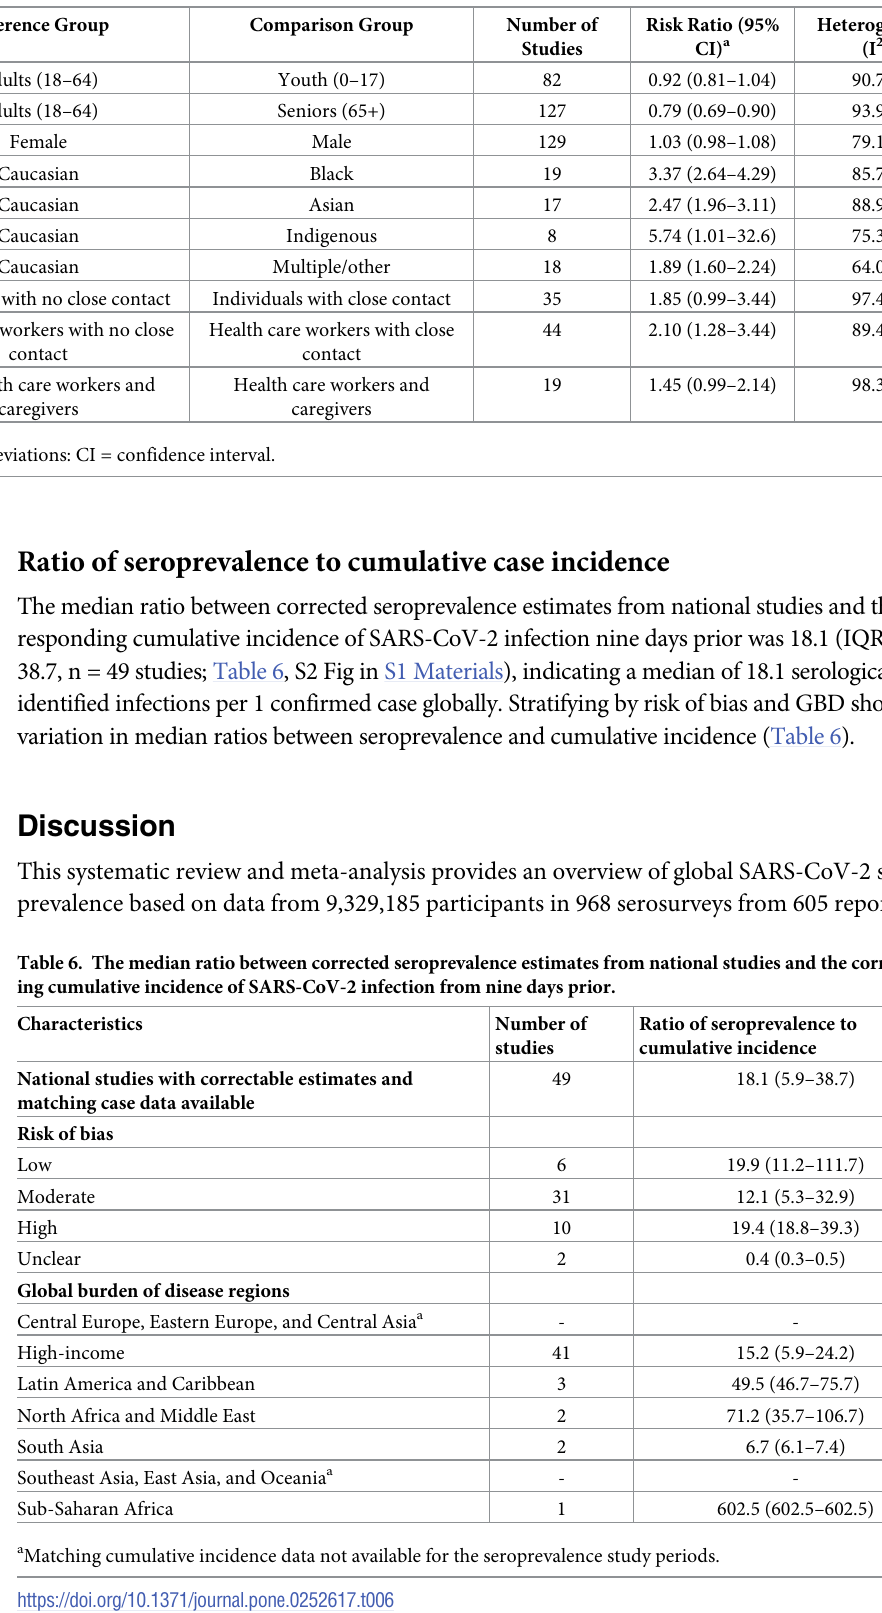
Table 5. Differences in seroprevalence estimates by demographic characteristics within studies. Factor